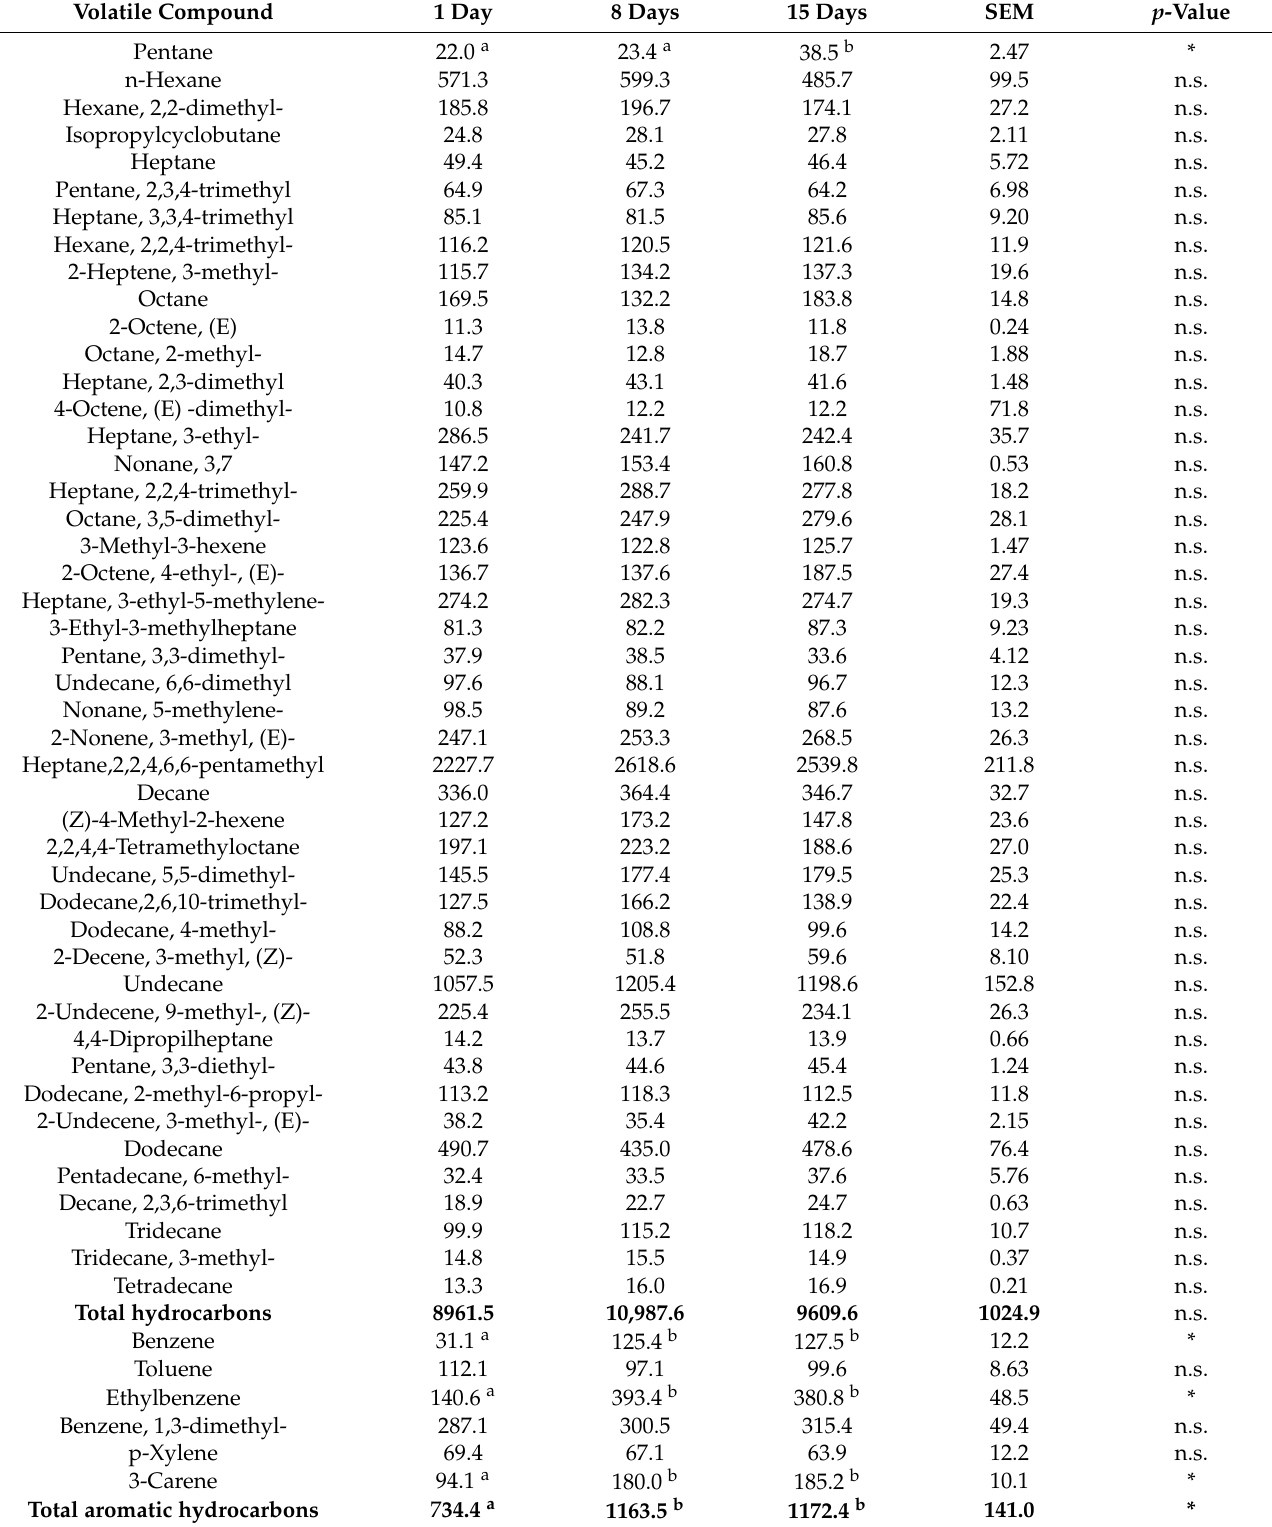
Table 4. Effects of ageing period on donkey meat hydrocarbon and aromatic hydrocarbon content (AU × 10 3